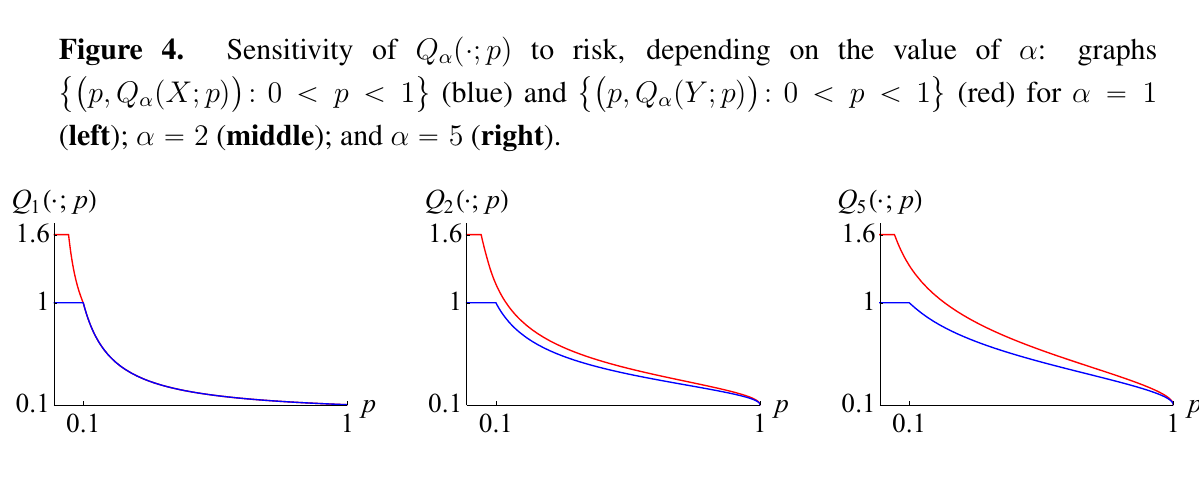
p¨ ; p q to risk, depending on the value of α : graphs α